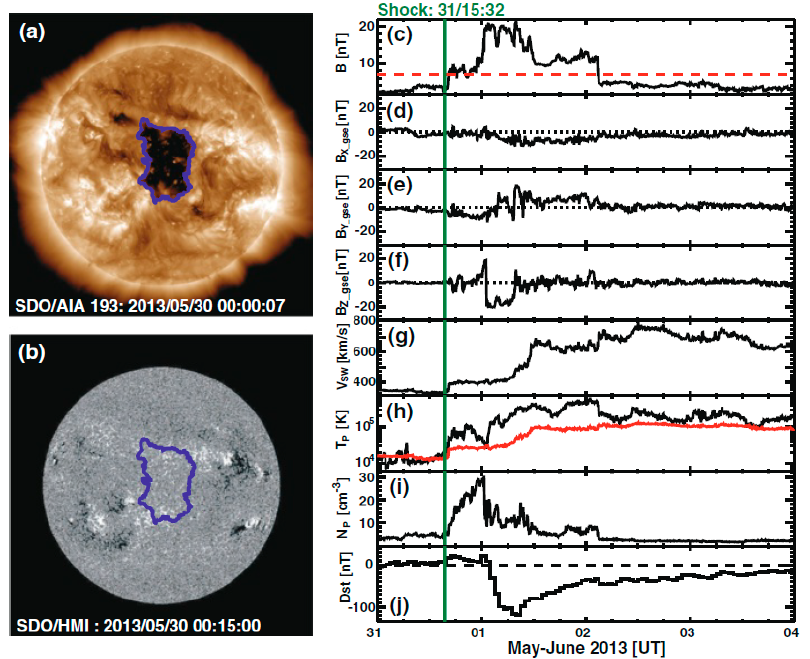
Figure 14. A low-latitude coronal hole observed by SDO/AIA at 193 Å ( a ), the underlying photo- spheric magnetic field strength from SDO/HMI ( b ), and solar wind parameters inaround the CIR with a leading shock ( c ) [from Gopalswamy et al. 2015]. The coronal hole was near the central me- ridian on 30 May 2013 and resulted in an intense storm ( − 119 nT) on 1 June. Magnetic field compo- nents Bx, By, and Bz are shown in panels ( d – f ), respectively. The three indicators of a stream inter- action region are the increase in solar wind speed ( g ), increasing temperature ( h ), and density peak ( i ). The Dst index ( j ) shows an intense storm (Dst < − 100 nT).